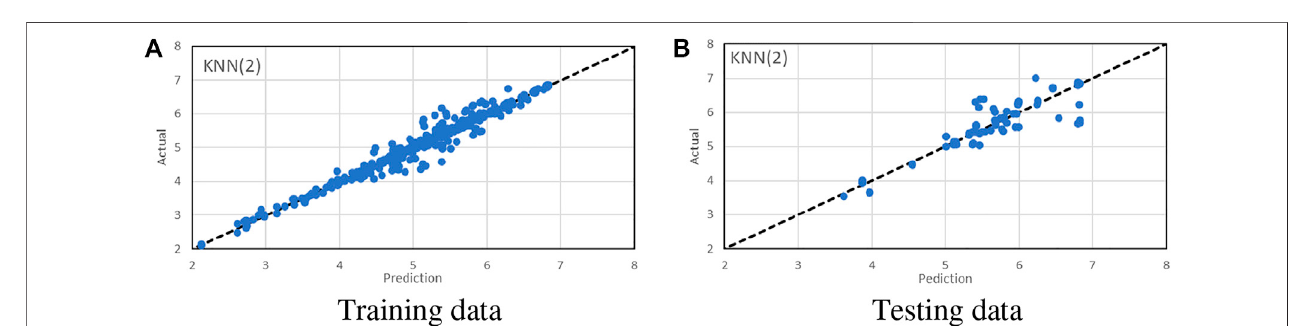
FIGURE 7 | Actual vs. prediction of KNN (2)